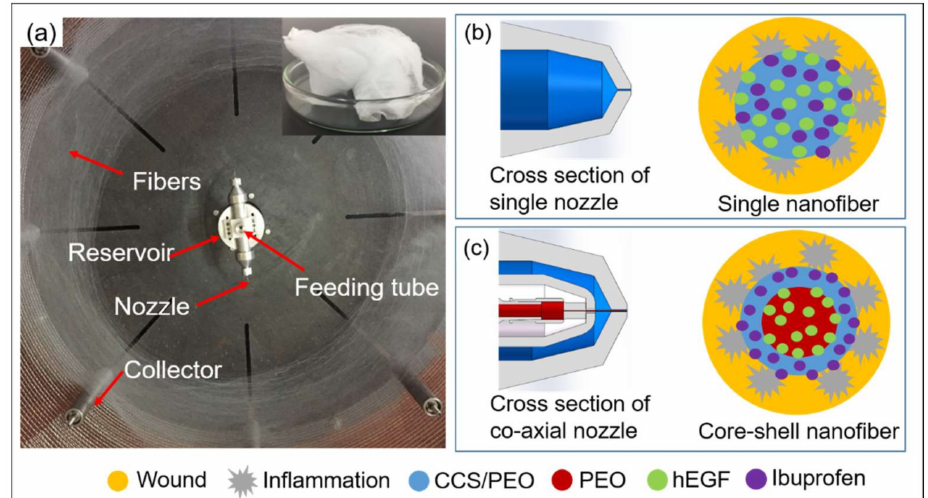
Figure 1. ( a ) Centrifugal spinning machine and the collected 3D structured nanofibers; schematic diagrams of ( b ) monoaxial nanofibers with drugs and ( c ) core-shell nanofibers with drugs in a wound